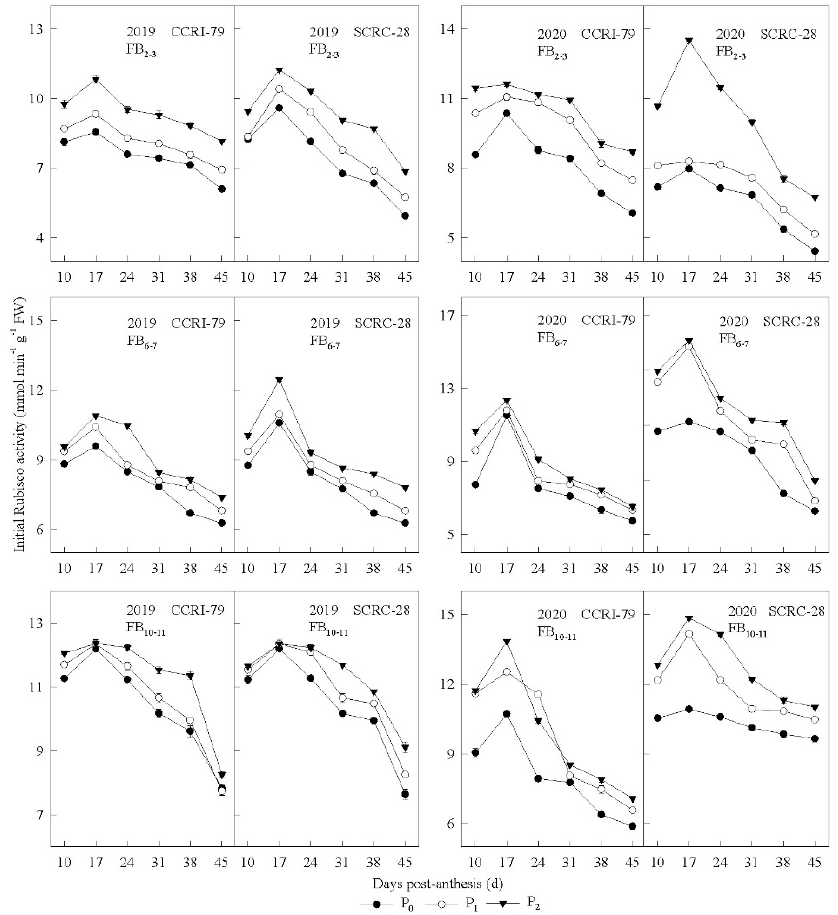
Figure 7. The effect of soil available phosphorus (AP) on the initial ribulose-1,5-bisphosphate carboxylase-oxygenase (Rubisco) activity of subtending leaves in 2019 and 2020 cotton-growing seasons. d: day. FB: fruiting branch. P 0 : 3 ± 0.5 mg kg − 1 . P 1 : 6 ± 0.5 mg kg − 1 . P 2 : 15 ± 0.5 mg kg − 1